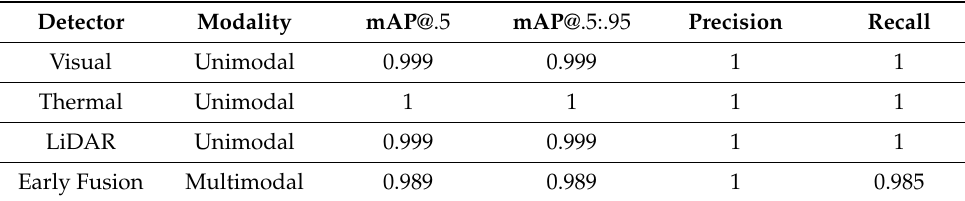
Table 2. The performance of each detector on its own test set.